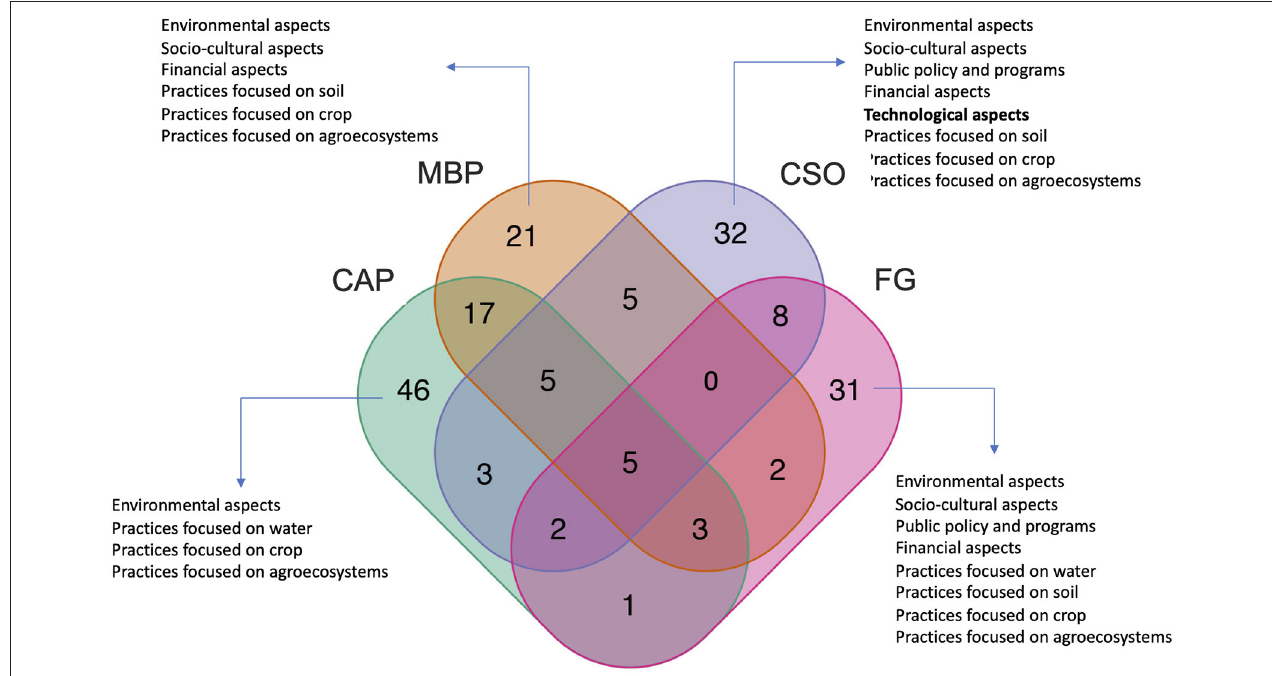
FIGURE 11 | Venn diagram showing the number of exclusive concepts and the categories in which these fell for each one of the sectors. In bold a category mentioned only by one of the four sectors (see details in Supplementary Material 4 ).